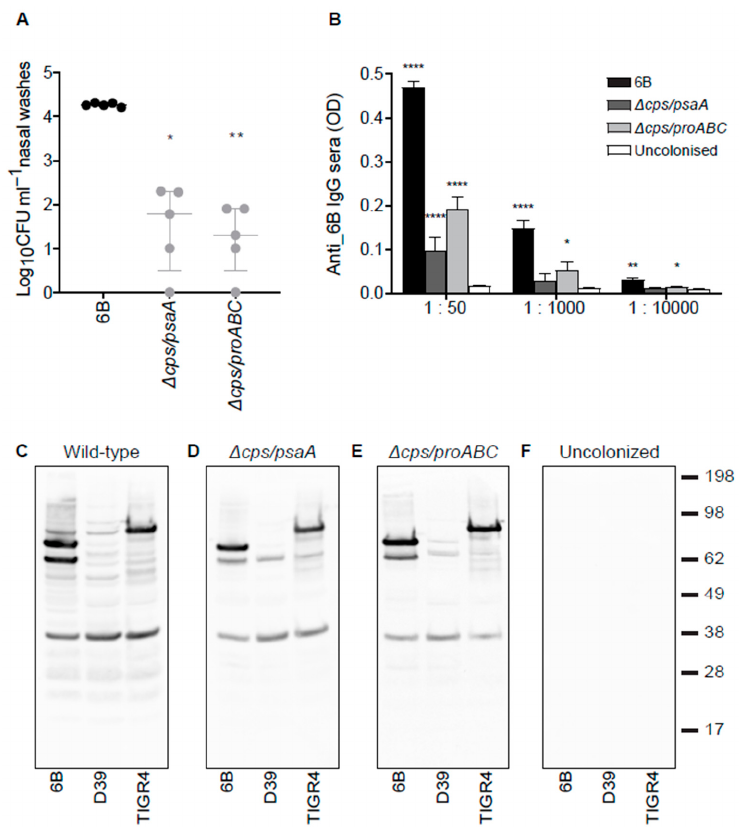
Figure 4. Wild type 6B and the unencapsulated double mutant strains induce a systemic antibody response after nasopharynx colonisation. ( A ) Colonisation model; nasal wash CFU 7 days post colonisation of CD1 mice with 1 × 10 7 CFU of wild type 6B or the double mutant S. pneumoniae strains. ( B ) Whole-cell enzyme-linked immunosorbent assay (ELISA) anti-6B immunoglobulin (Ig)G responses in mouse sera 28 days post-colonisation with the corresponding strain 6B (black bars), ∆ cps/psaA mutant (dark grey bars), ∆ cps/proABC mutant (light grey bars) compared with uncolonised controls (white bars). N = 5 for each group and the data analysed using Kruskal-Wallis with Dunn’s post hoc test to identify significant differences between selected groups; *, p < 0.05; **, p < 0.01 ****, p < 0.0001. ( C – F ) IgG immunoblots for whole-cell lysates of three different S. pneumoniae strains (6B, D39 and TIGR4) probed with sera obtained 28 days after two episodes of colonisation with 6B ( C ), ∆ csp/psaA ( D ), ∆ cps/proABC ( E ) strains, or from PBS sham colonized mice ( F